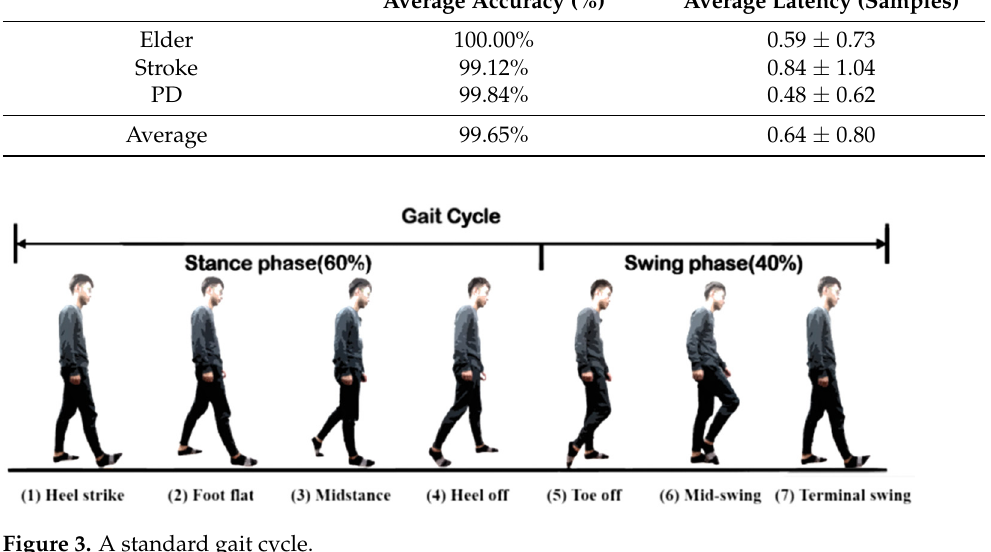
Figure 3. A standard gait cycle.